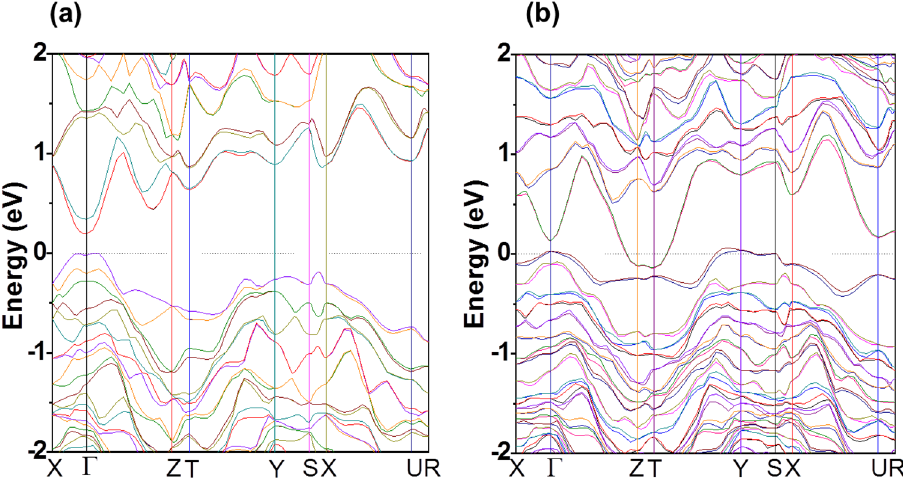
Figure 4. Electronic band structure of ( a ) In 4 Se 3 and ( b ) In 4 Se 3- δ ( δ = 0.25). Reproduced with permission from AIP Publishing LLC, 2009